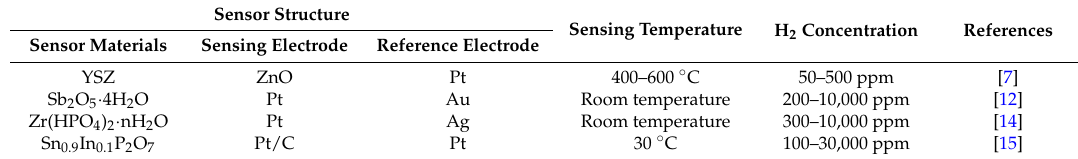
Table 1. Typical examples of mixed-potential gas sensors for H 2 detection. YSZ: yttria-stabilized zirconia.